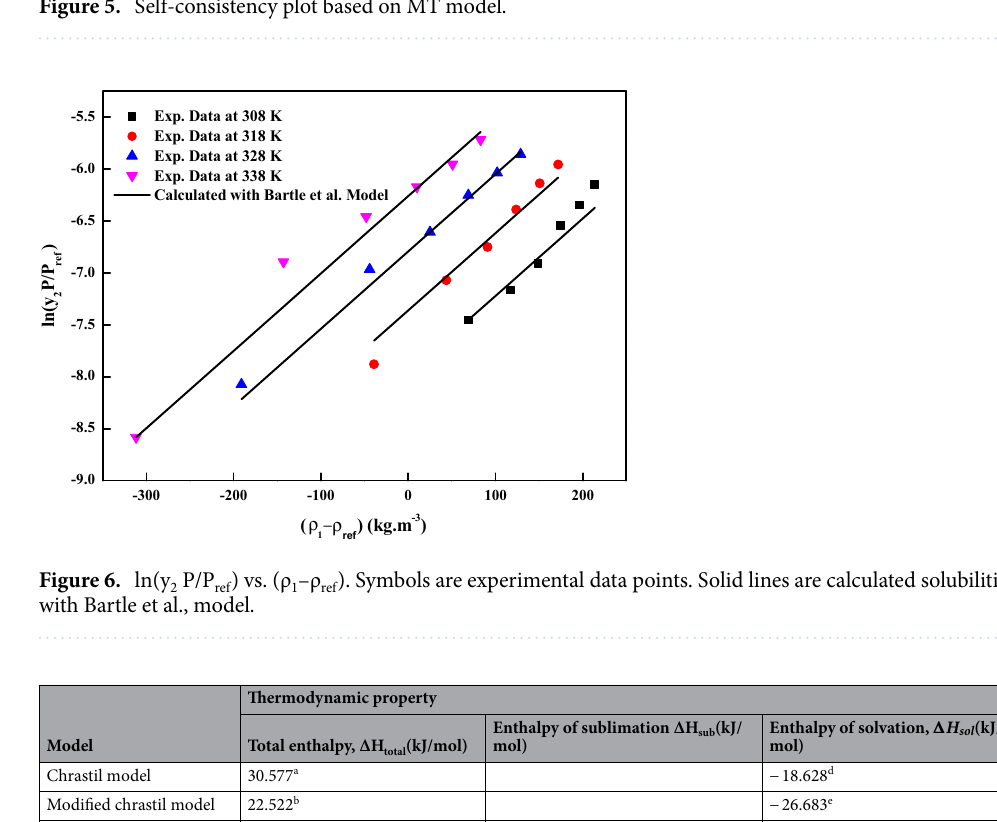
Figure 5. Self-consistency plot based on MT model.